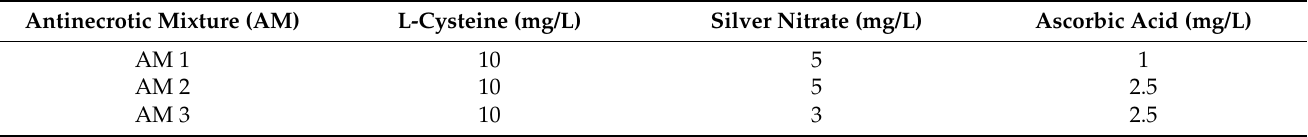
Table 2. Composition of different types of antinecrotic mixtures (AM) used for pretreatment of the calli. Antinecrotic Mixture (AM) L-Cysteine (mg/L) Silver Nitrate (mg/L) Ascorbic Acid